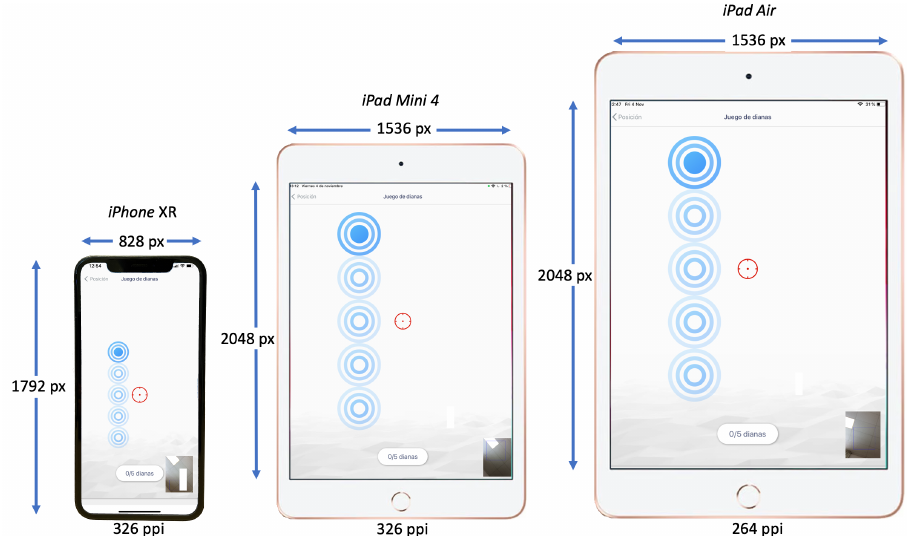
Figure 4. Screen sizes and resolutions of the Apple iPad XR , the Apple iPad Mini 4 and the Apple iPad Air . As an illustration of the potential effect of the different screen sizes and resolutions of the devices, each of the devices displays the same view of the running